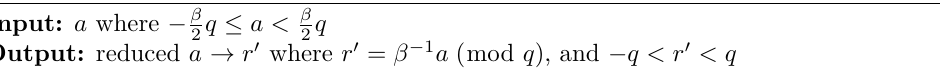
Algorithm 11 Signed Montgomery reduction using Montgomery factor β = 2 16 .